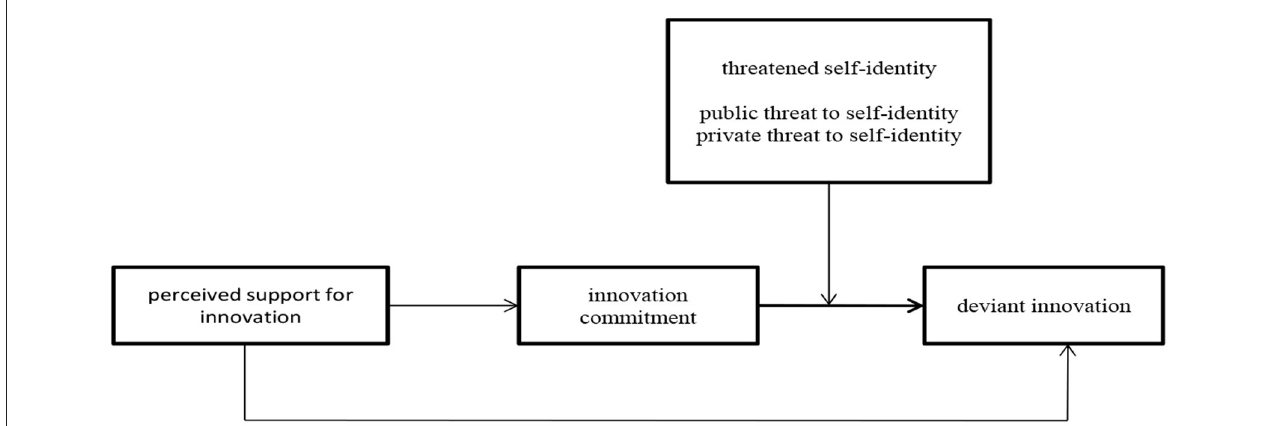
FIGURE 1 | Proposed research model. Source: own